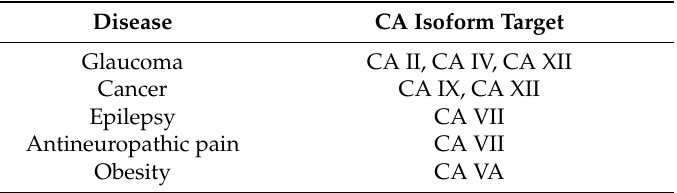
Table 1. Carbonic anhydrase (CA) related diseases with associated isoform targets.